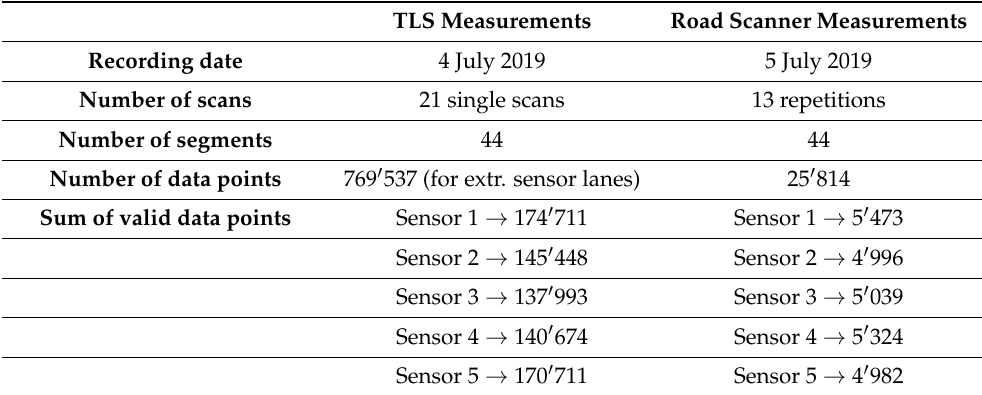
Table 1. Overview of the collected data, including the number of valid data points per sensor lane within the defined segments.